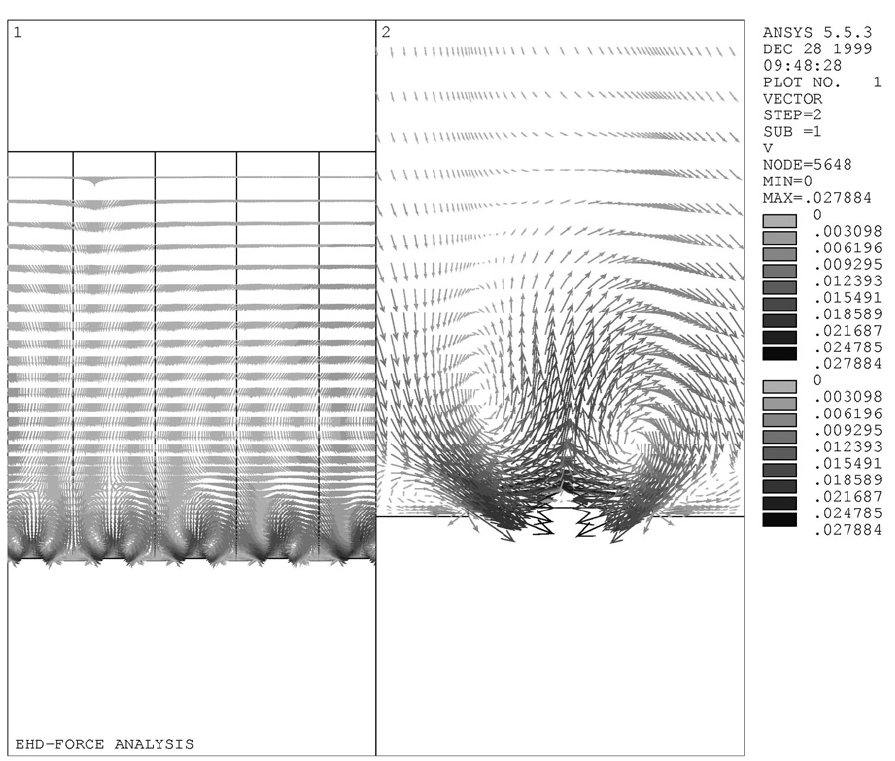
Fig. 9–Fluidmotionbehaviorat10kHz, foraninterdigitatedelectrodearraymodeledbya2-DFEMmodel. Ontheleft-side a few electrode domains are shown, while on the right-side a zoom of the neighborhood of an electrode is